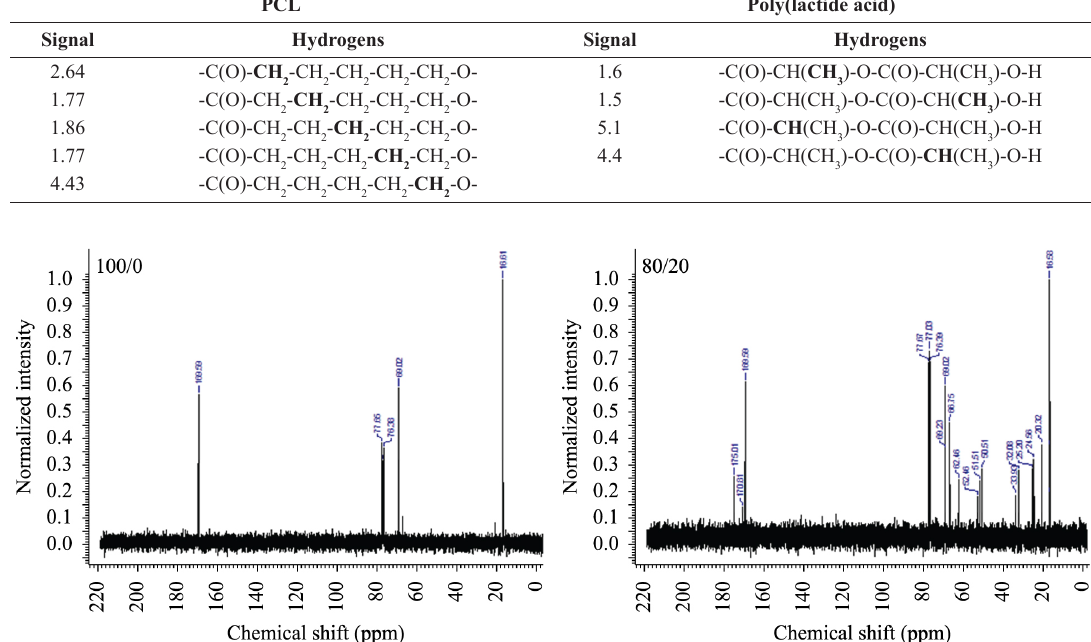
Table 3. Signals of 1 H-NMR for PCL and PLLA, obtained from reactions of ring-opening using Sn(Oct) 2[2,15,17] . PCL Poly(lactide acid)